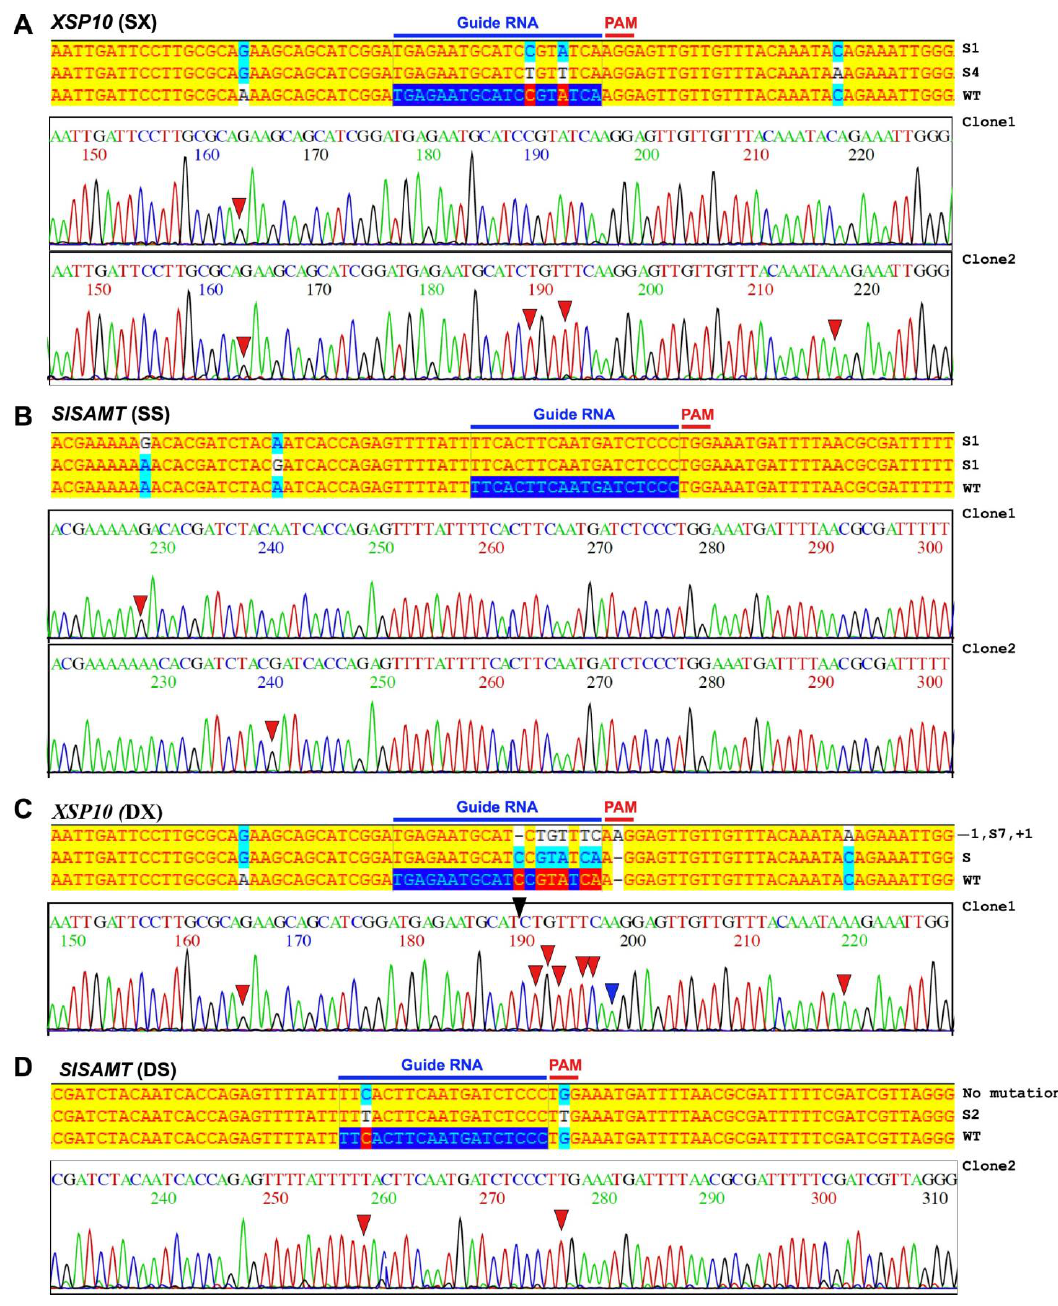
Figure 1. Evaluation of single-gene and dual-gene CRISPR editing events of XSP10 and SlSAMT through Sanger sequencing. ( A ) XSP10 single-gene editing (SX) events showing 1-bp (S1) and 4-bp (S4) substitution mutations in clone 1 and clone 2. Wild-type (WT) sequence of XSP10 used as a reference sequence. The mutations in nucleotides of each clone indicated as ‘ − ’ for deletion, ‘+’ for insertion, and ‘s’ for substitution. The bold blue arrows underlined 19-nucleotide sgRNA seed sequences along with PAM sites in the reference gene sequence. In the chromatogram, the red arrow indicates ‘s’, blue indicate ‘+’, and black ‘ − ’ for insertion. ( B ) SlSAMT single-gene editing (SS) events showing 1-bp (S1) substitution mutation in clone 1 and 2. ( C ) Dual-gene editing (DXS) of XSP10 (DX) showing 7-bp substitution (S7), 1-bp insertion (+1), and 1 bp-deletion ( − 1) observed in clone 1. ( D ) SlSAMT (DS) showing 2-bp substitution (S2) in clone 2 and no mutation in clone